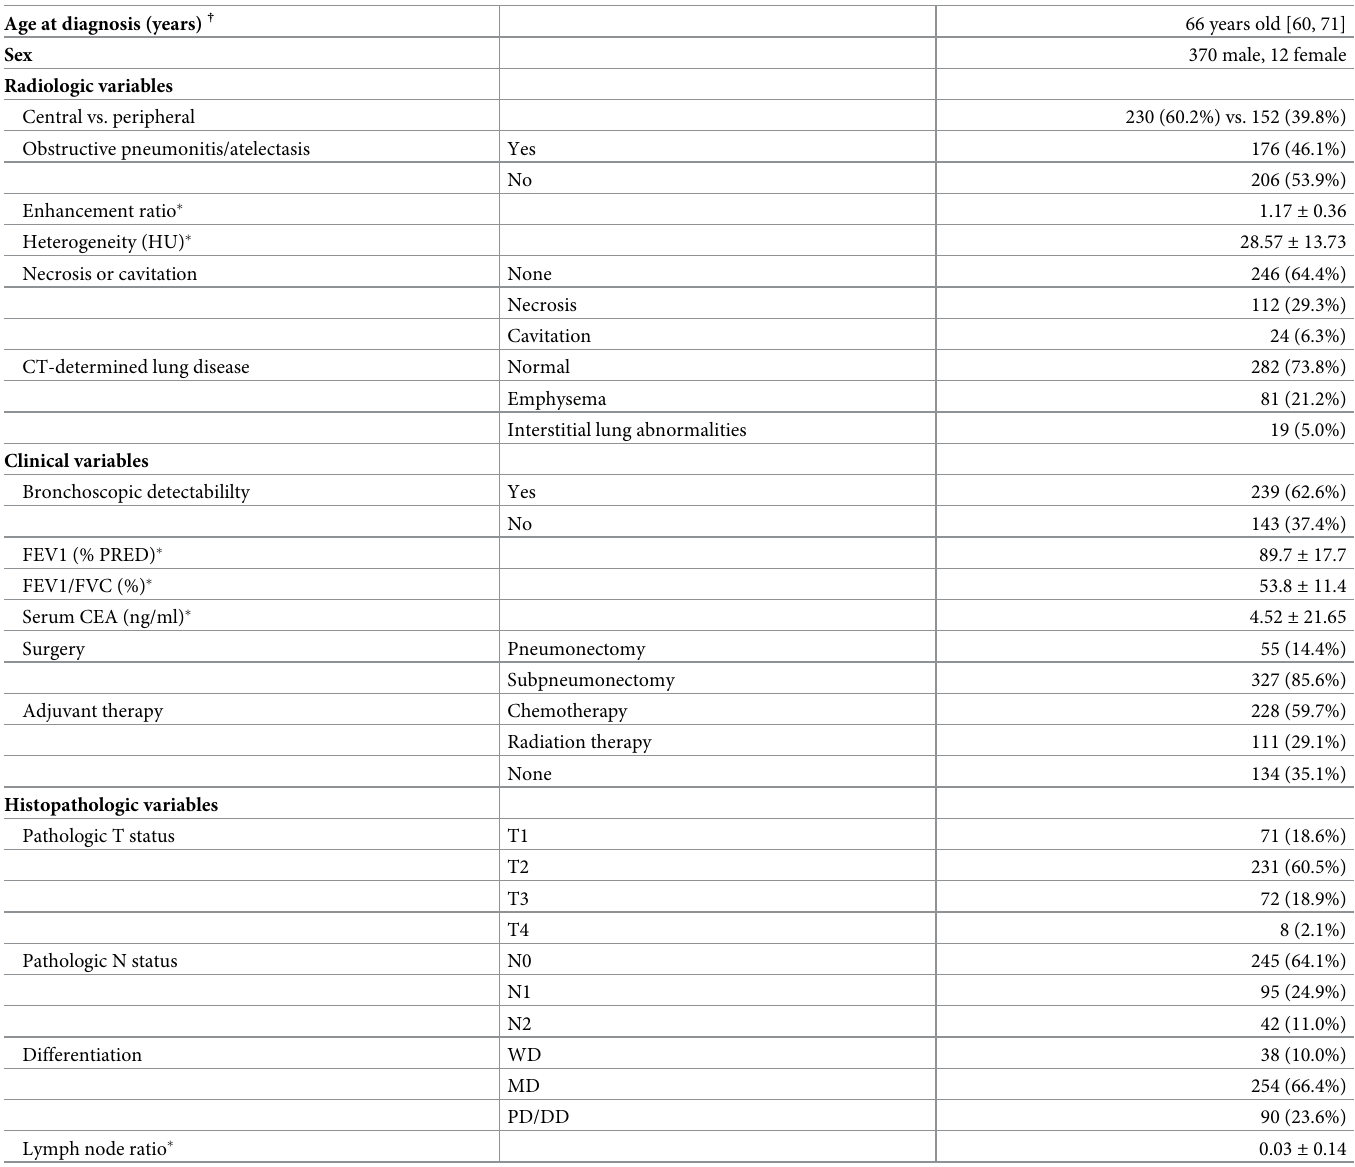
Table 1. Patient